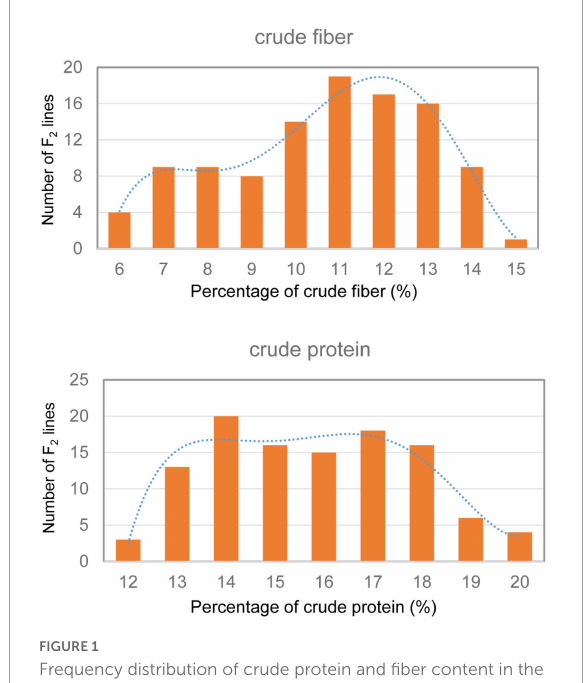
FIGURE1 Frequency distribution of crude protein and fiber content in the F 2 population derived from cultivated ZSZ1 and wild tenacissima. Blue dashed line indicates the frequency distribution trend. The x -axis indicates the percentage (%) of crude protein and fiber, and the y -axis indicates the number of F 2 lines.